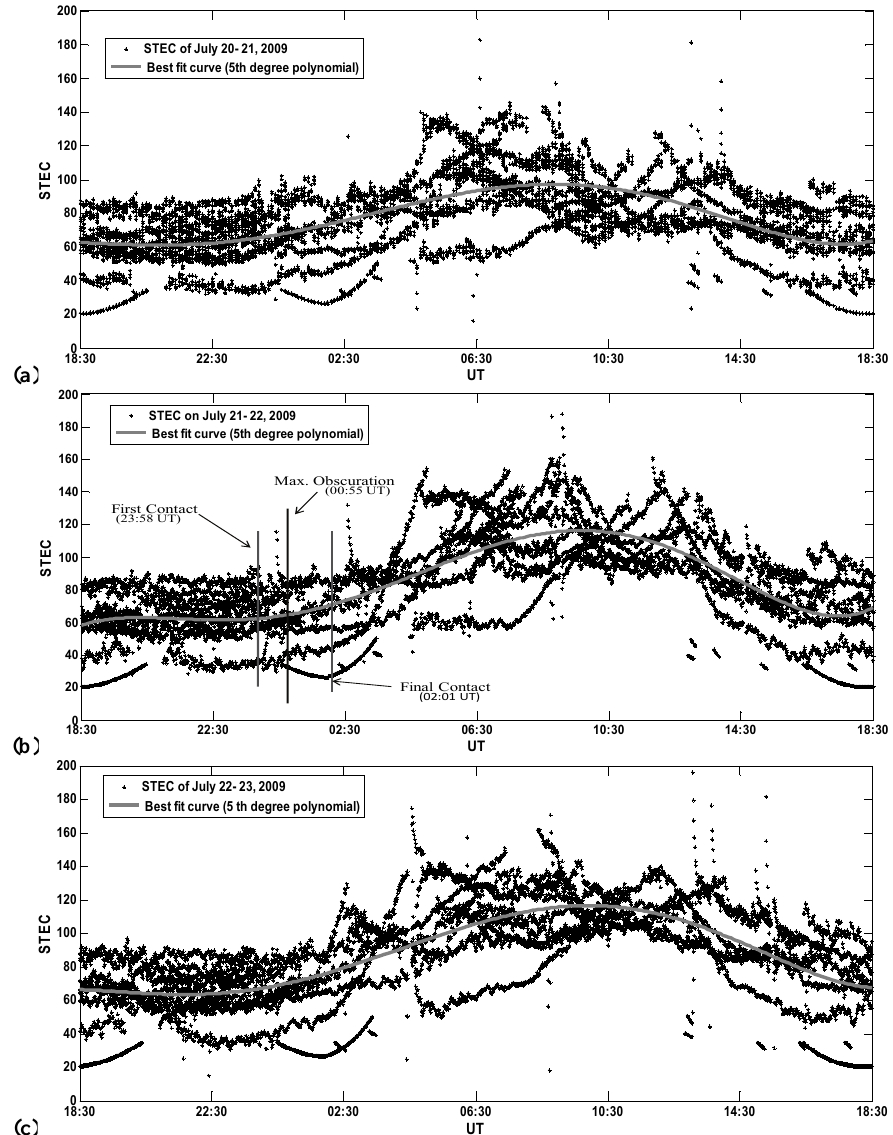
Fig. 2. Diurnal variation of slant TEC (STEC) as observed from Kharagpur during the period 20–21 July 2009, 21–22 July 2009, 22– 23 July 2009 are shown in (a) , (b) and (c) respectively. A polynomial of degree 5 which best fits the variation is shown in